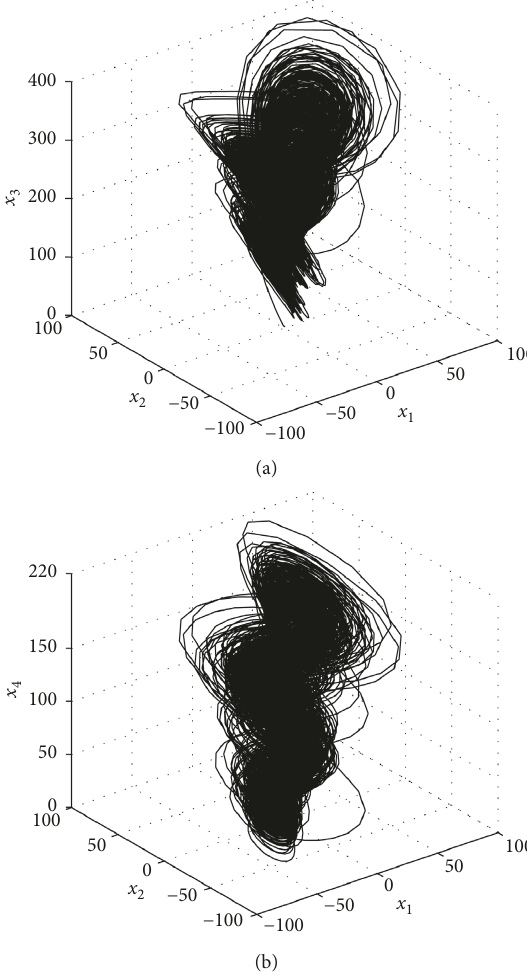
Figure 1: Fractional-order chaotic attractor: (a) ( x (b) ( x 1 - x 2 - x 4 )